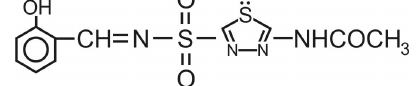
Figure 1 . Structure of Schiff